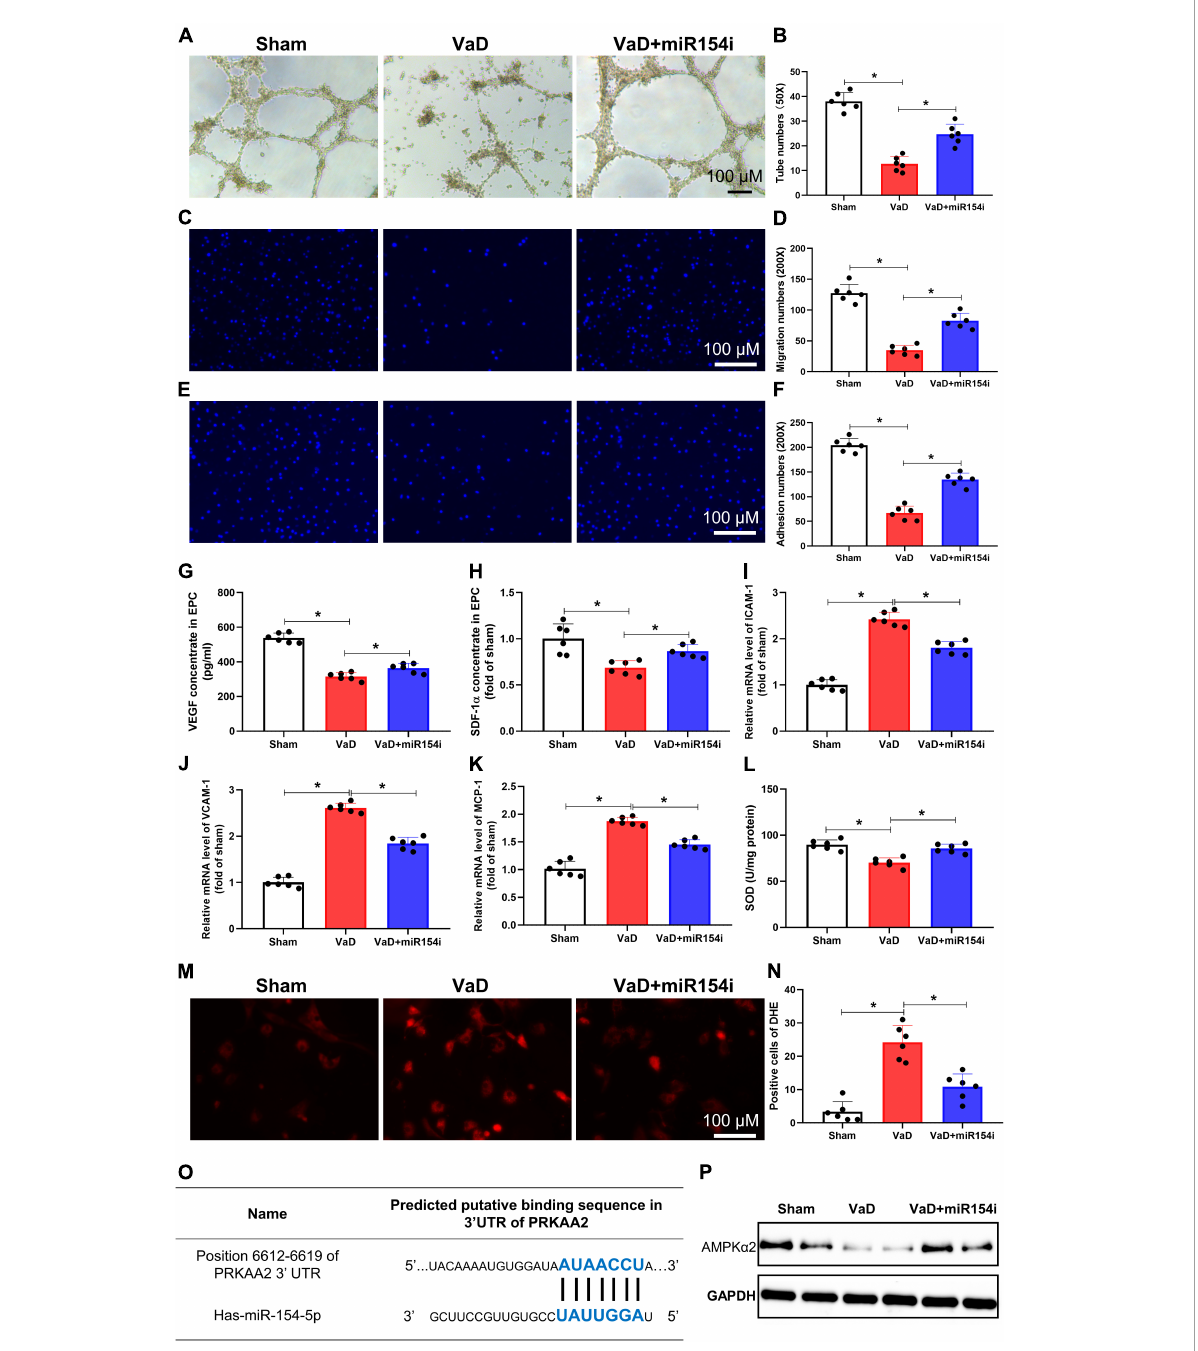
FIGURE4 Inhibition of miR-154-5p improves VaD-induced EPC dysfunction and reduces oxidative stress in BM-EPCs. After 3 months of bilateral common carotid artery occlusion surgery, rats were euthanized, and BM-EPCs were harvested for functional tests. BM-EPC function was estimated by tube formation assay (A,B) , migration ability (C,D) , and adhesion capacity (E,F) . MiR-154-5p inhibitor significantly improved VaD-induced EPC dysfunction. The levels of VEGF (G) and SDF-1 α (H) in culture medium were detected by ELISA kits. Results from the real-time PCR experiments for analysis the expression of ICAM-1 (I) , VCAM-1 (J) , and MCP-1 (K) in BM-EPCs. (L) SOD level in BM-EPCs was measured with a kit. Images of DHE staining (M) and quantitative analysis of DHE-positive cells (N) . (O) The predicted miR-154-5p-binding sites in PRKAA2 mRNA 3 (cid:48) -UTR were confirmed. (P) The downregulated level of AMPK α 2 was increased by miR-154-5p inhibitor in BM-EPCs. 50 × : scale bar, 100 µ m; 200 × : scale bar, 100 µ m [ (A–N) : n = 6; (P) : n = 3]. * p < 0.05. Data are shown as mean ± SD. BM-EPC, bone marrow-endothelial progenitor cell; SDF, stromal cell-derived factor; SOD, superoxide dismutase; VaD, vascular